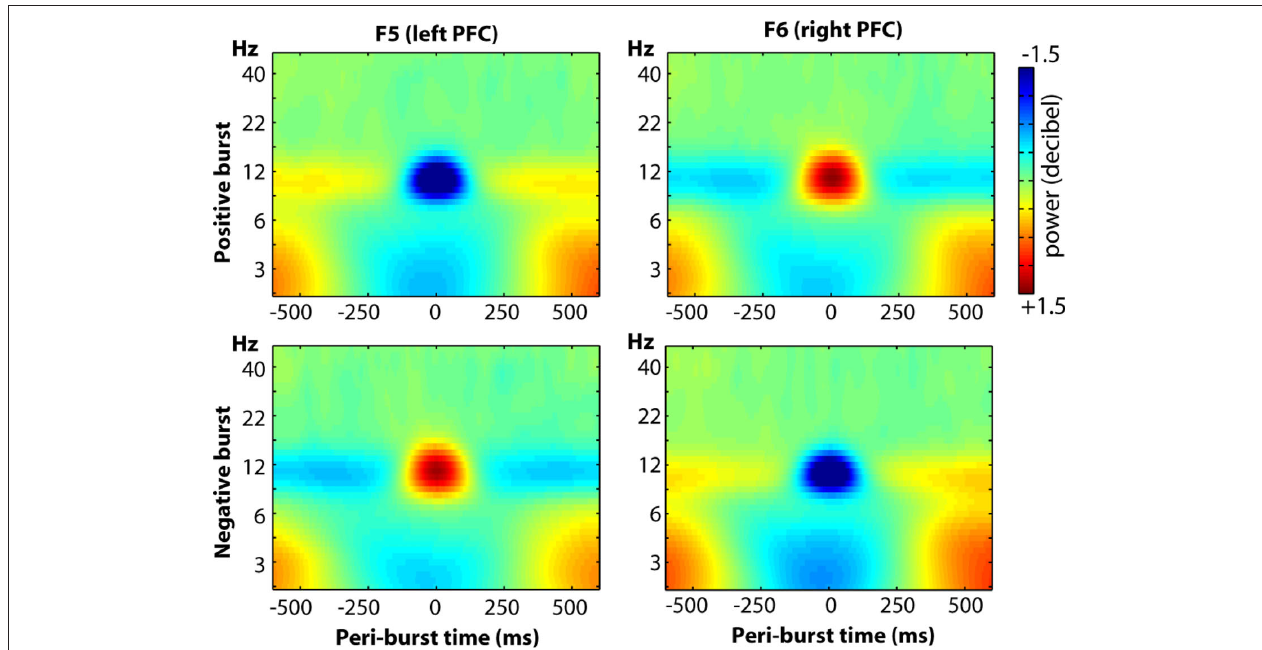
FIGuRE 13 | The oscillatory dynamics of a wider frequency range for sites F5 and F6, displayed as a function of positive and negative bursts.